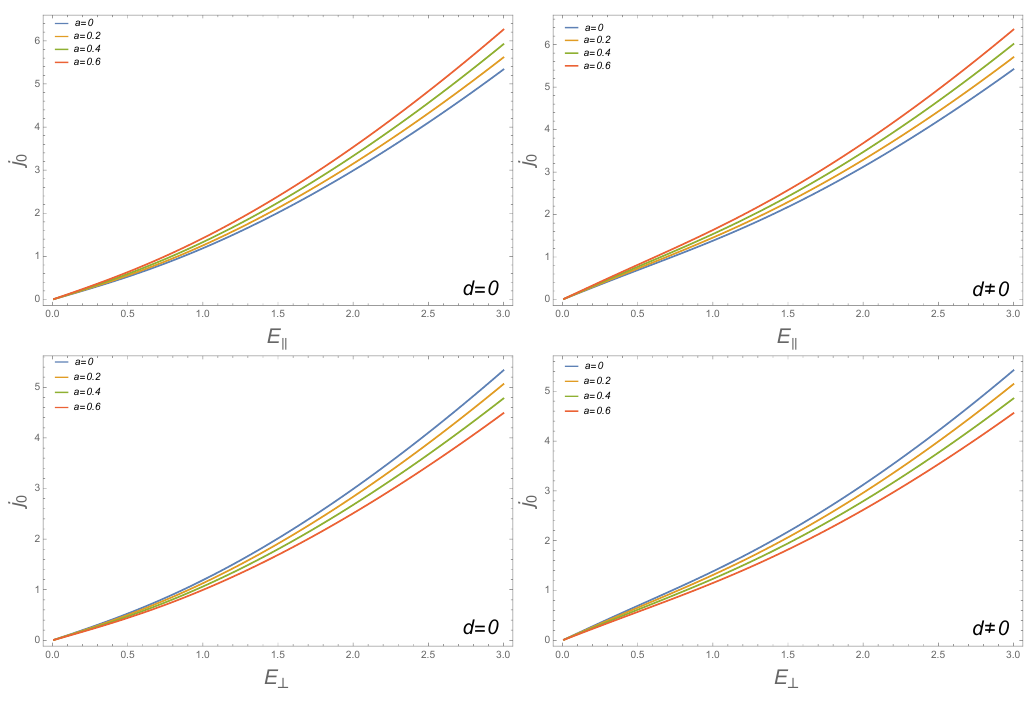
Figure 14 . Relation of j 0 and electric field E